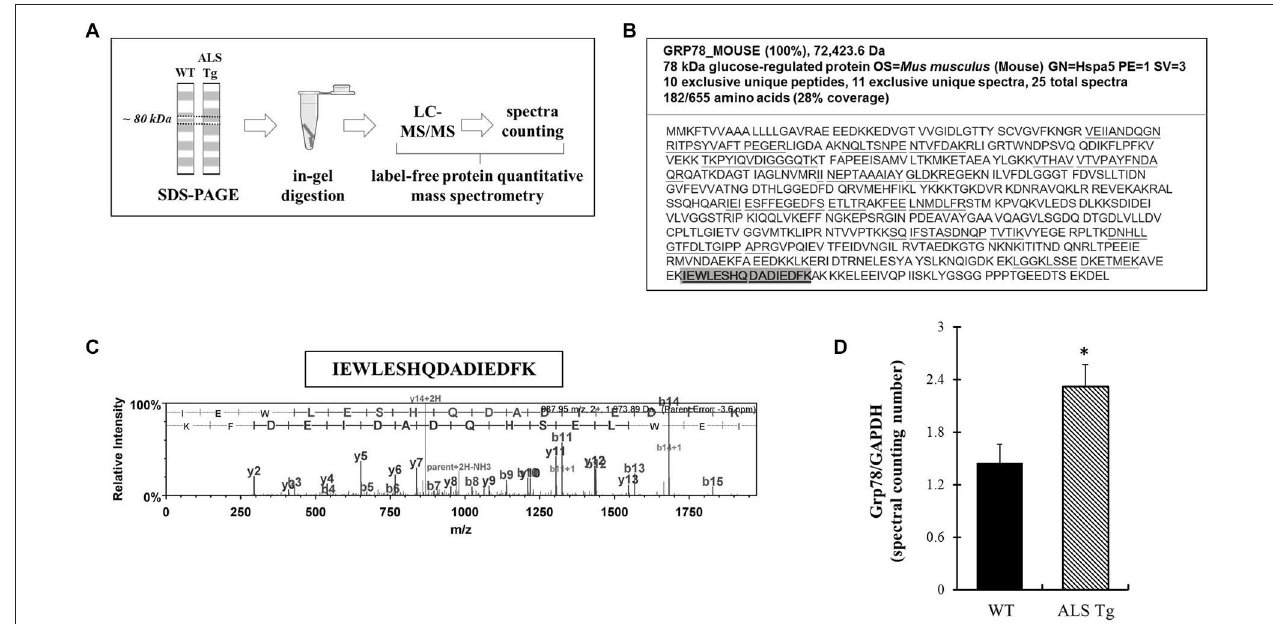
total spectra numbers. (B) Grp78/BiP protein identification and peptide coverage using LC-MS/MS. (C) Representative mass-to-charge ratio spectrum and b-/y ions fragmentation of Grp78/BiP peptide (highlighted in B ). (D) Protein quantitative data analysis using the ratio of normalized total spectra numbers of Grp78/BiP to a house keeping protein GAPDH. Three independent muscles from 120–140d old wild type (WT) and ALS-Tg mice were analyzed. * p < 0.05, WT vs. ALS-Tg.